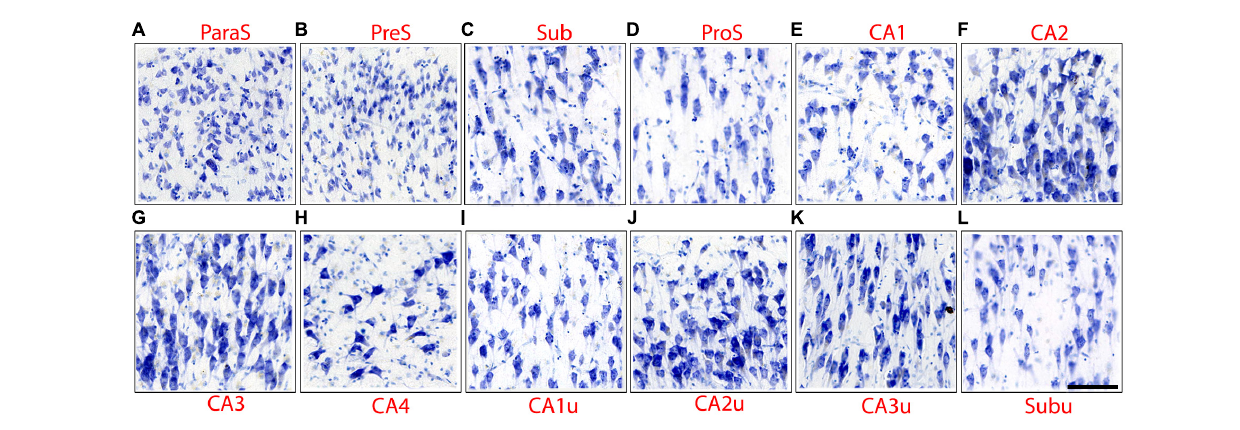
FIGURE2 Microscopic images depict the neuronal characteristics, as outlined in the pentad protocol, of the hippocampal subfields. Images have been positioned so that the superior portion of the pyramidal layer is on the top of the image. Note that CA2 (F) , CA3 (G) , and CA4 (H) display intense chromophilia in their pyramidal neurons as well as medial counterparts CA2u (J) and CA3u (K) . Subfields CA1 (E) , Sub (C) , and ProS (D) show a moderate amount of chromophilia, as do their medial counter parts CA1u (I) and Subu (L) . ParaS (A) , PreS (B) , CA2, and CA3 present a dense packing density, while CA1, Sub, and CA4 display sparser neuronal populations. ParaS and PreS contain extremely small neurons in the superficial layer (layer II) while CA3 and CA4 in pyramidal layer exhibit the largest neurons. The CA2 and CA3 pyramidal neurons reveal the highest degree of